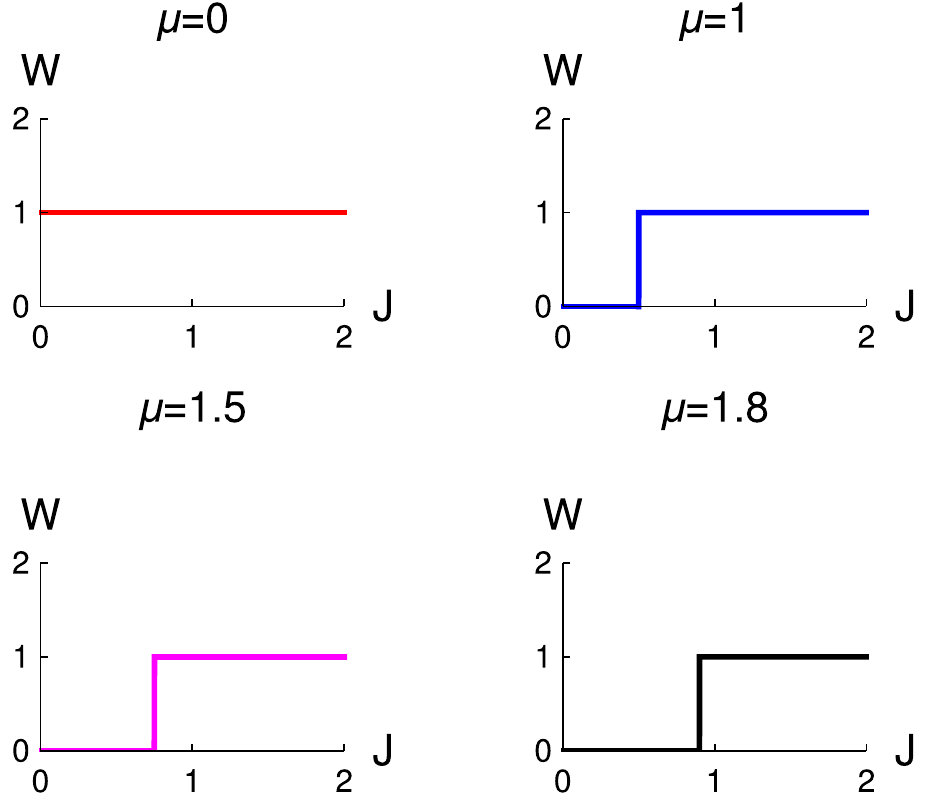
Figure 1. The variation of winding number ( W ) with J for different values of μ . Different figures are for different values of μ , red ( μ = 0), blue ( μ = 1.0), magenta ( μ = 1.5) and black ( μ = 1.8), Δ =